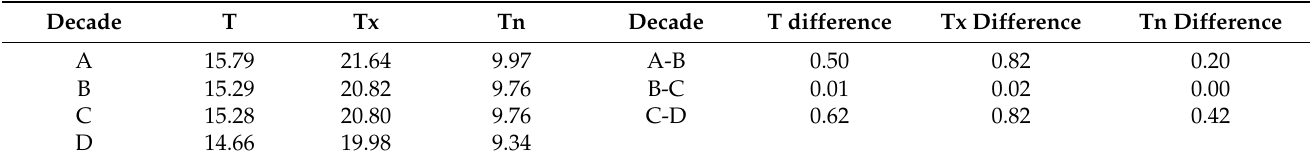
Table 2. Mean temperature over 10 years and difference between decades (2020–2011, A; 2010–2001, B; 2000–1991, C and 1990–1981, D).